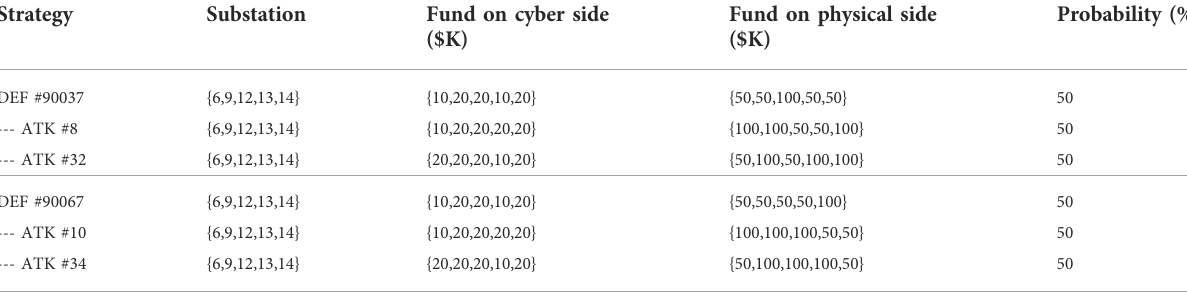
TABLE 10 Subgame perfect Nash equilibrium under speci fi c fund constraints.